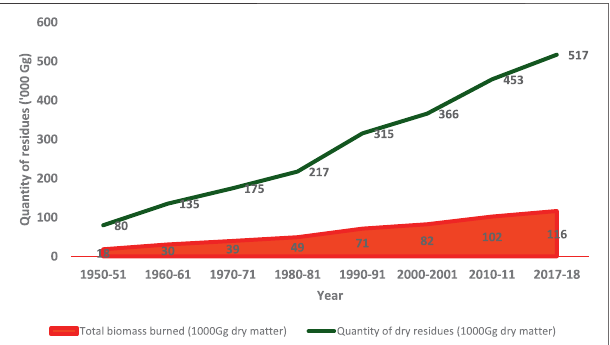
FIGURE 2 | Crop residues generation and crop residue burning in India between 1950 – 51 and 2017 – 18. Source: Crop statistics of India were obtained from the ‘ Agricultural Statistics at a glance 2018 ’ and ‘ Economic Survey.019 – -2020 ’ (Government of India, 2018; Economic Survey,